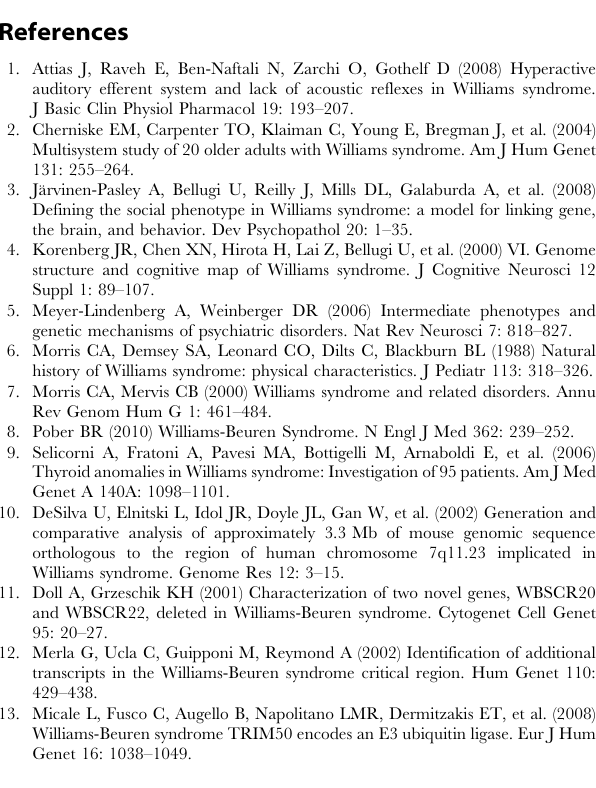
Figure S2 (A) Relationship between the number of times genes appear in transcription modules (M1, M2, or their union) and their number of connections in the STRING database. First row: genes were binned according to their frequency in modules, and the mean STRING degree of each bin is plotted. The line is the fit from the linear regression of STRING degree on frequency, the slope is always significant with a p-value less than 10 2 9 . Second row: the mean (black) and median (blue) degree is plotted for the genes that appear at least a given number of times in the modules. In other words, the first point is the mean/median degree of all genes, the second data point is the mean/median degree of all genes that appear at least once in a module, etc. There is a clear correlation between the frequency in the modules and STRING degree. (B) Relationship between the number of times genes appear in modules and their PageRank centrality in the STRING network. The plots are essentially the same as in (A), but the PageRank centrality is plotted instead of degree. There is a clear correlation between the frequency in the modules and the centrality of the genes in the STRING network. Table S1 Cell line information. Table S2 Differentially expressed genes in WBS samples compared to controls. Table S3 Differential expression of the WBS hemizygous and flanking genes. Table S4 Datasets used for modular analysis. Table S5 Dysregulated modules, M1.